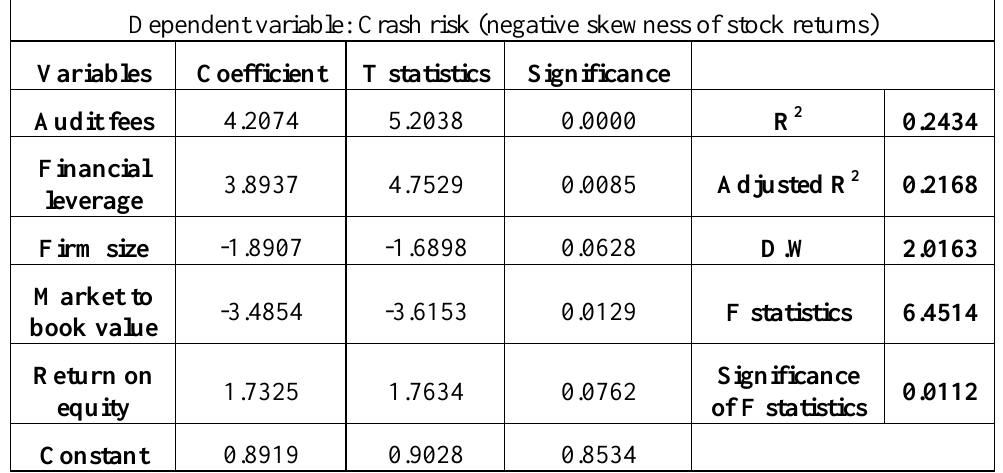
Table 4. Findings of the estimation of the regression model for testing the second hypothesis